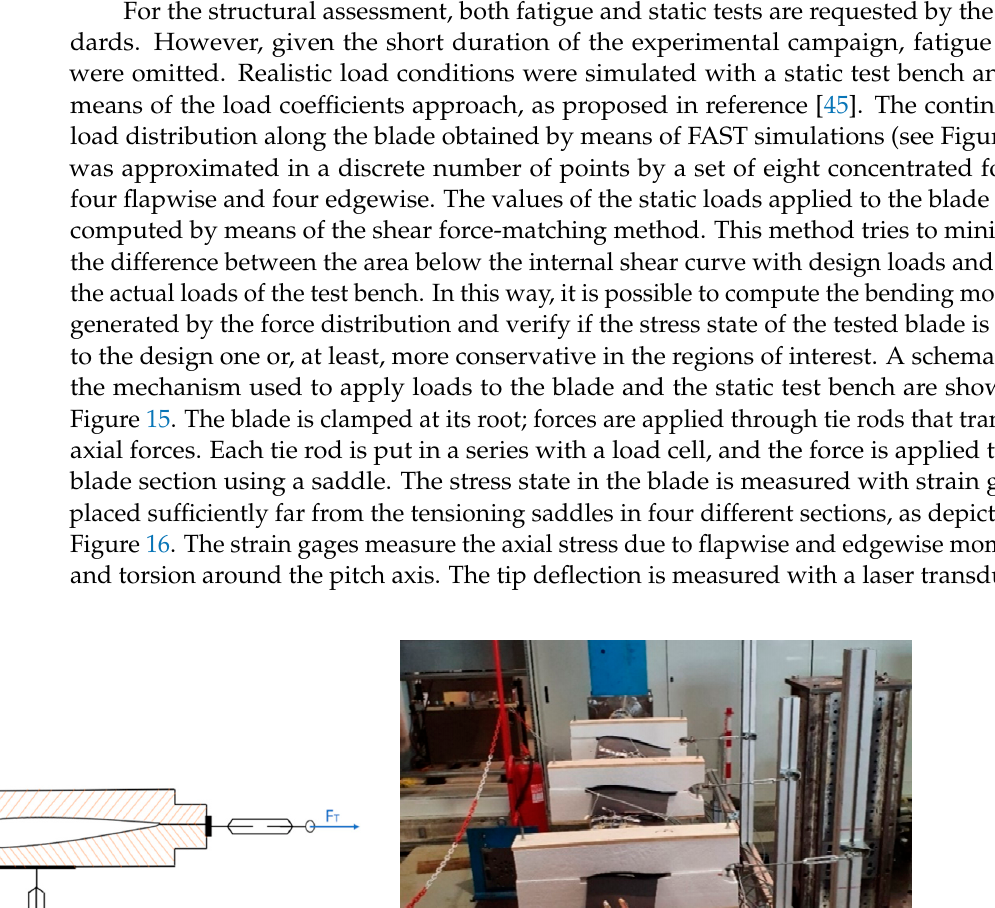
( b ) Figure 16. Strain gages arrangement on a blade section ( a ). Strain gages and accelerometers along the blade ( b ). Two are the main outcomes of the static test: one side the blade is tested with respect to the design loads, and its resistance is assessed; on the other side, the experimental data can be used to verify the FEM model of the blade. The validated FEM model is then utilized to assess the blade resistance with a more realistic continuous-load distribution. To verify the fidelity of the FEM model, the blade is loaded with a force in the flapwise direction at the tip, and the tip displacement is measured for several load values. A comparison of the experimental data and FEM model predictions is shown in Figure 17.